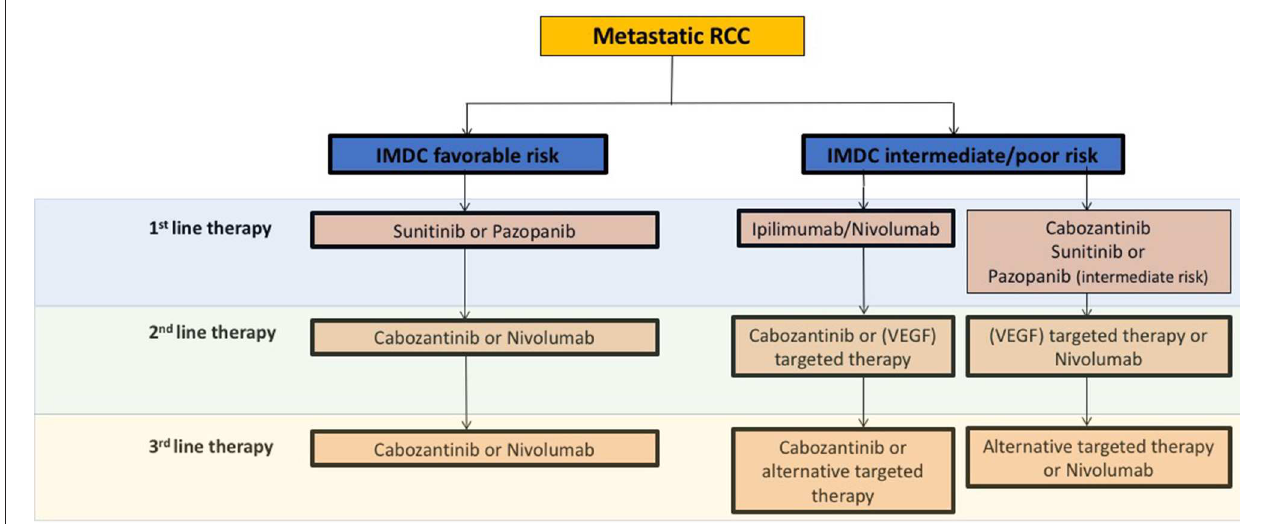
FIGURE 1 | Schematic overview and recommendations from the current European Association of Urology 2018 guidelines for systemic treatment in mRCC. VEGF, vascular endothelial growth factor; IMDC, The International Metastatic Renal Cell Carcinoma Database